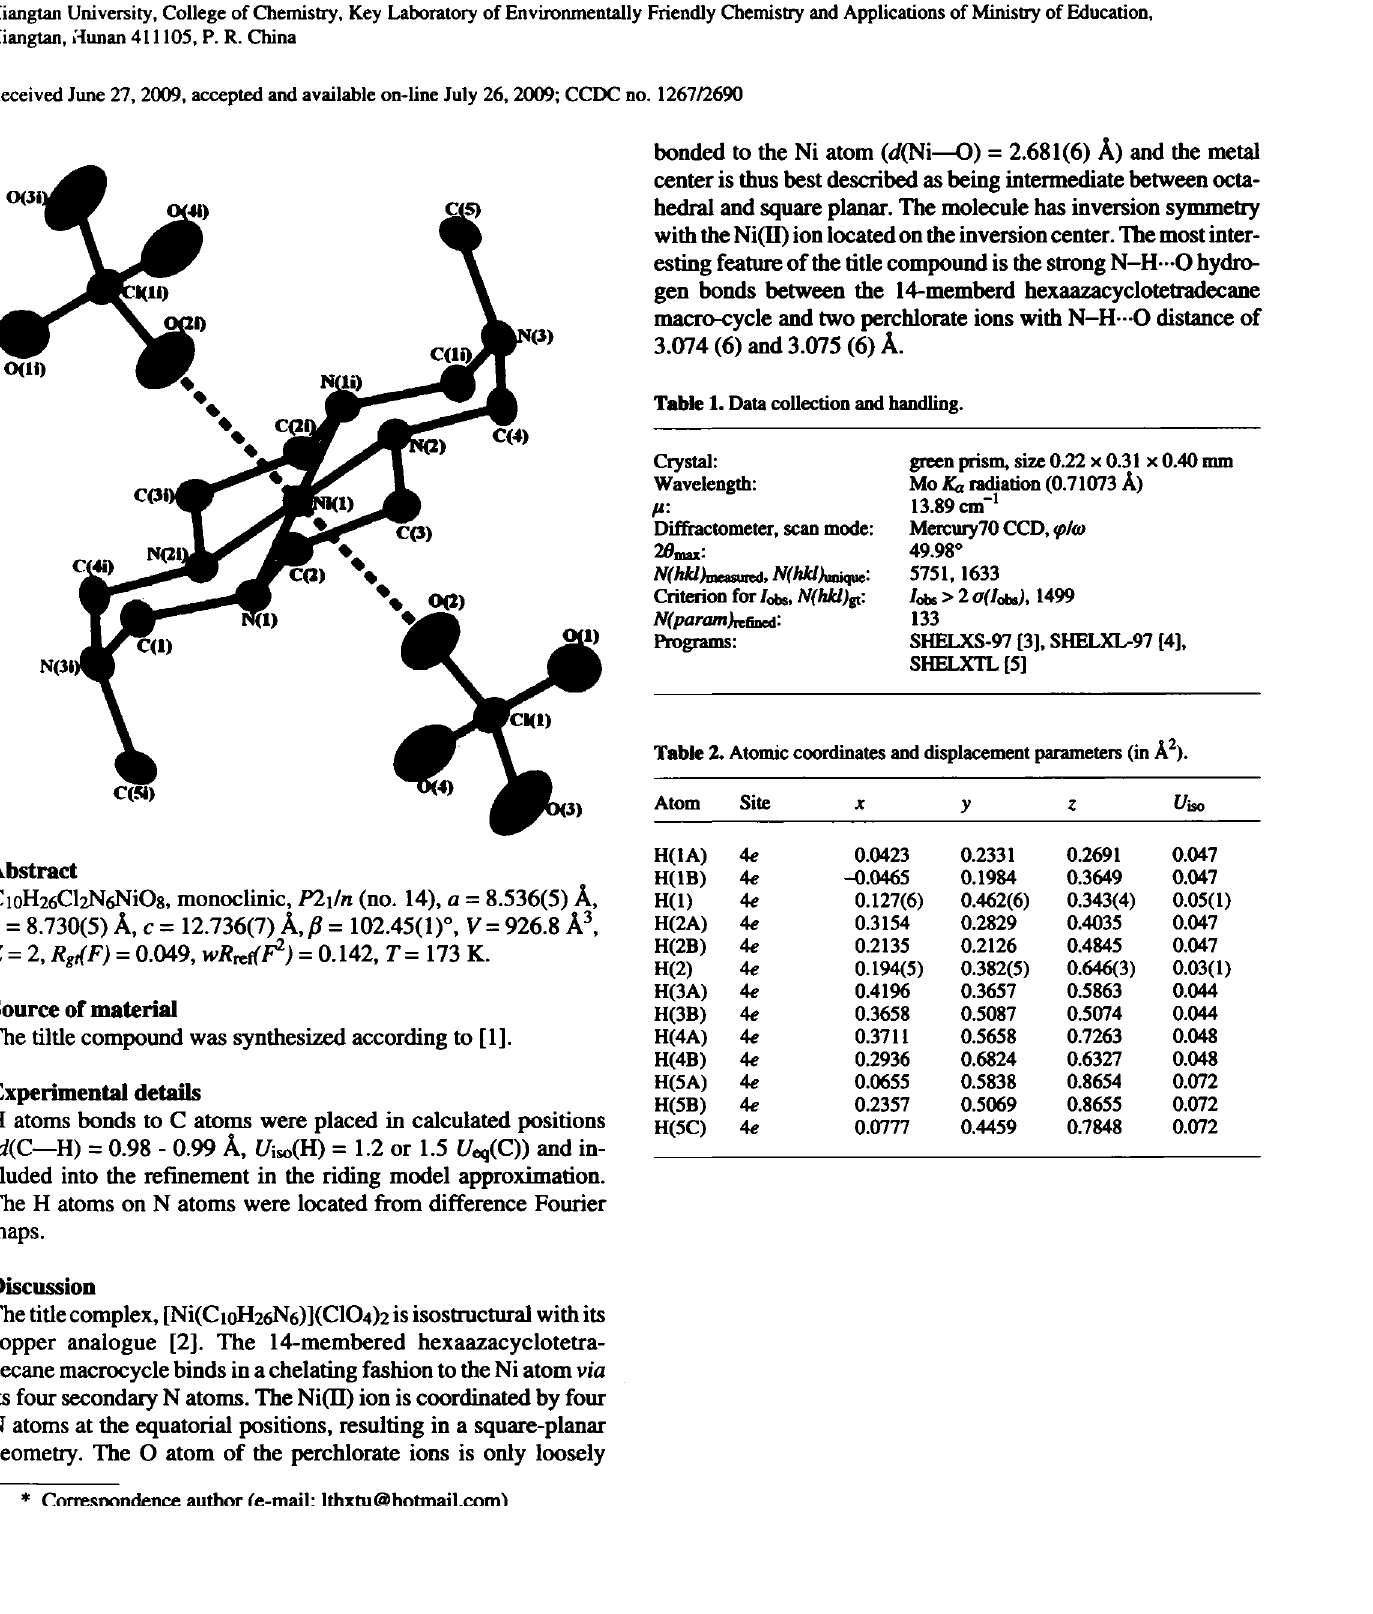
Table 1. Data collection and handling. Crystal: